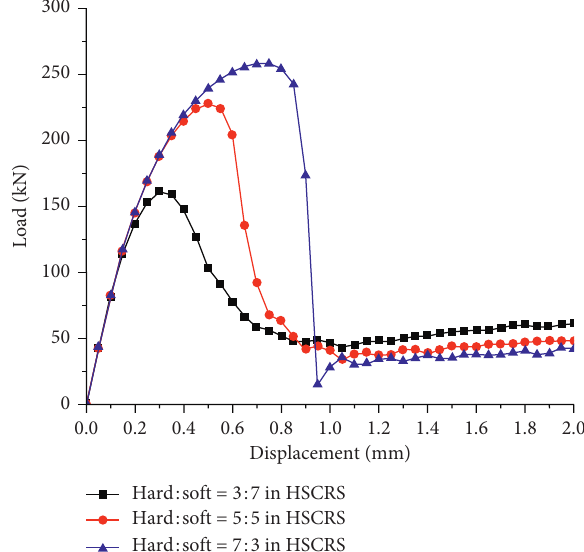
Figure 16: Comparison of load-displacement curves of soft to hard thickness ratios (3: 7, 5 :5, and 7: 3) in HSCRS.